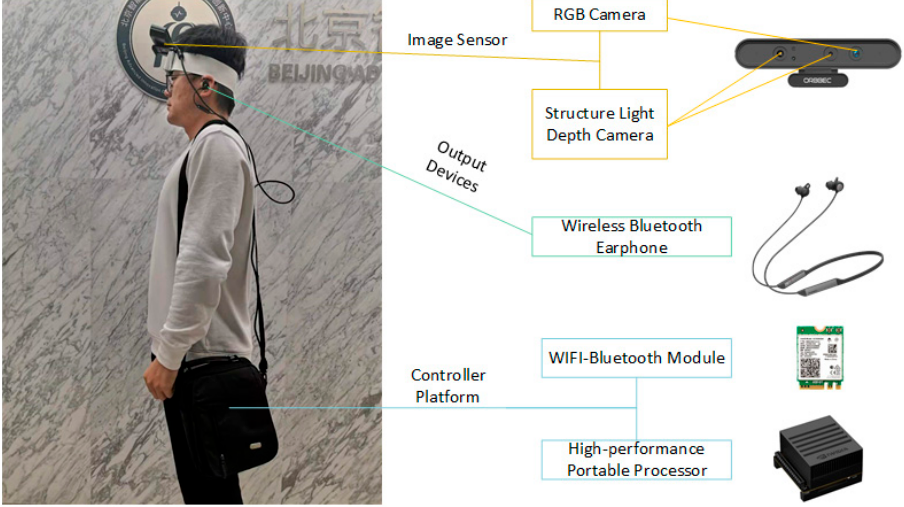
Figure 5. The wearable navigation system platform. Table 1. SLAM trajectory